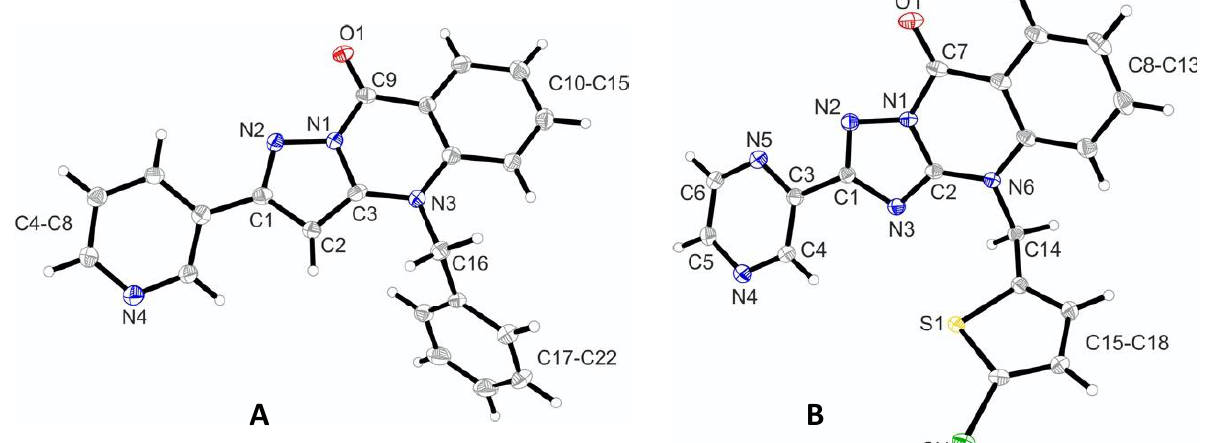
Figure 3. X-ray crystal structure of 10a displaying the thermal ellipsoids at the 50% probability level ( A ); X-ray crystal structure of 19 displaying the thermal ellipsoids at the 50% probability level ( B ).